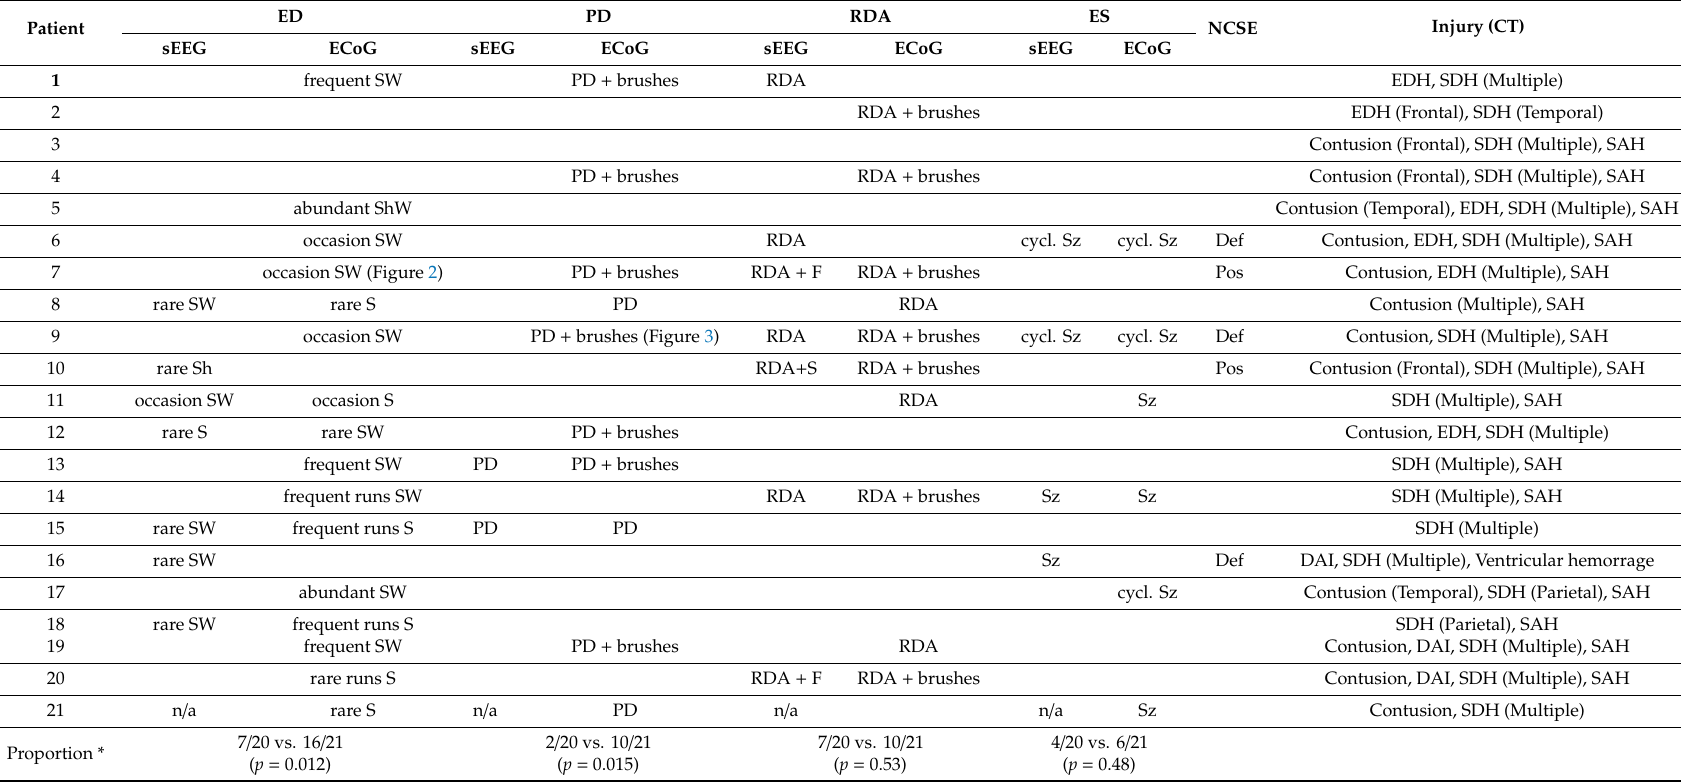
Table 1. Pathological activities in scalp electroencephalograms (EEGs) and ECoGs, in patients after traumatic brain injury